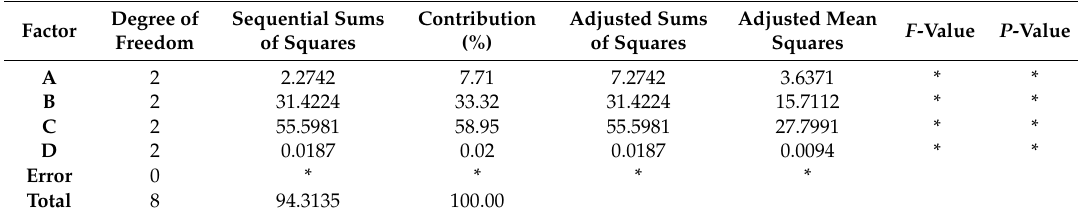
Table 4. ANOVA results for Sc.